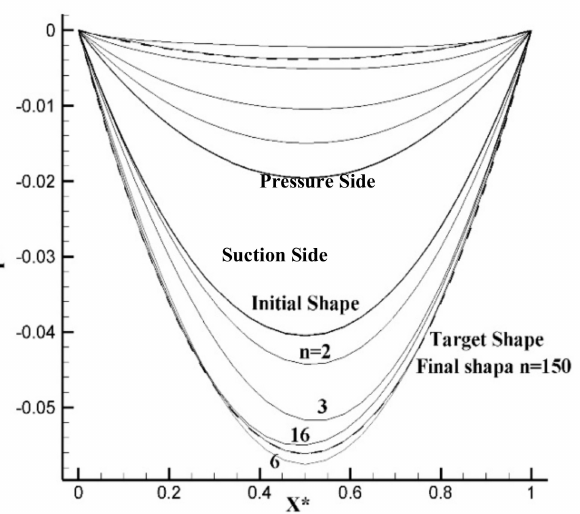
Figure 3. Contours of Mach number for a blade cascade with transonic flow regime.